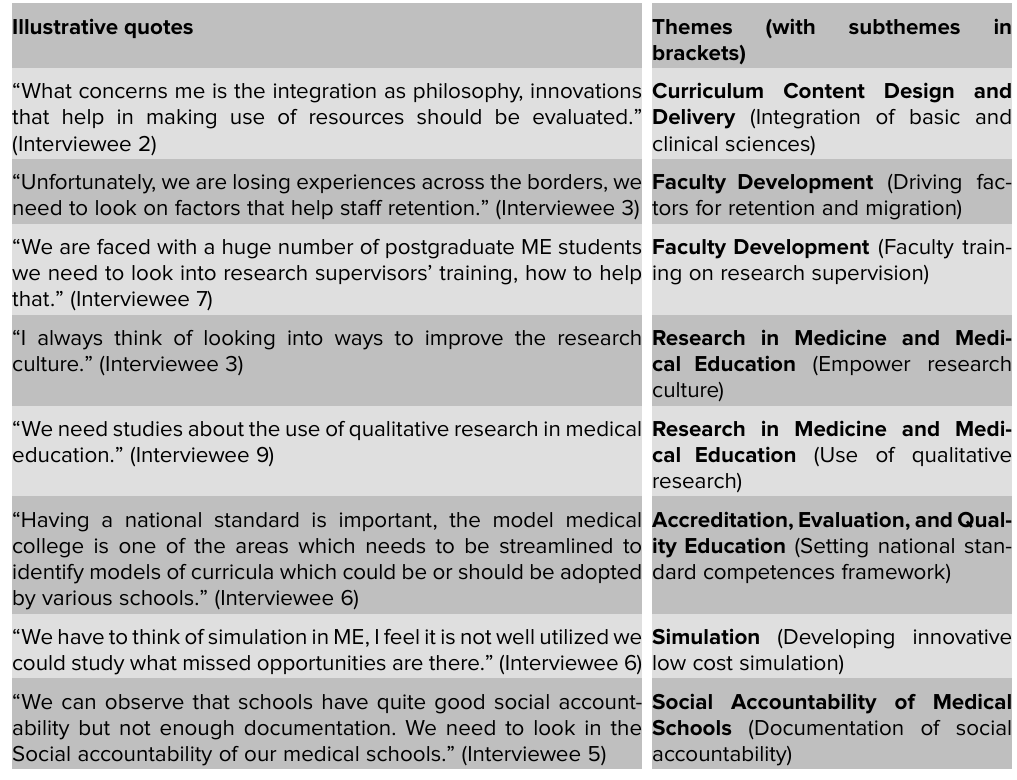
Table 1: Illustrative quotes with relevant themes and subthemes: Experts’